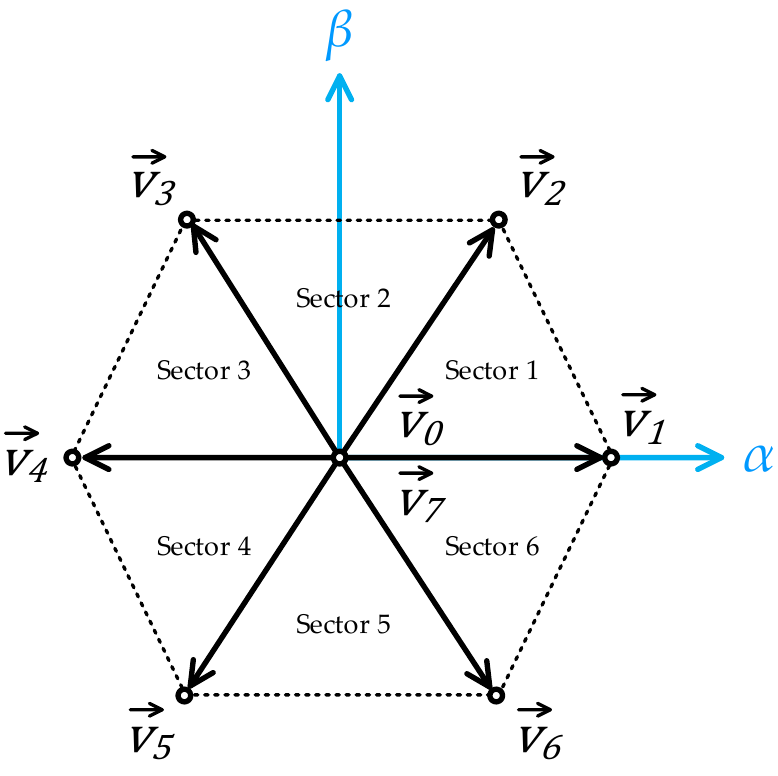
Figure 2. Three-phase two-level VSI space vector diagram.